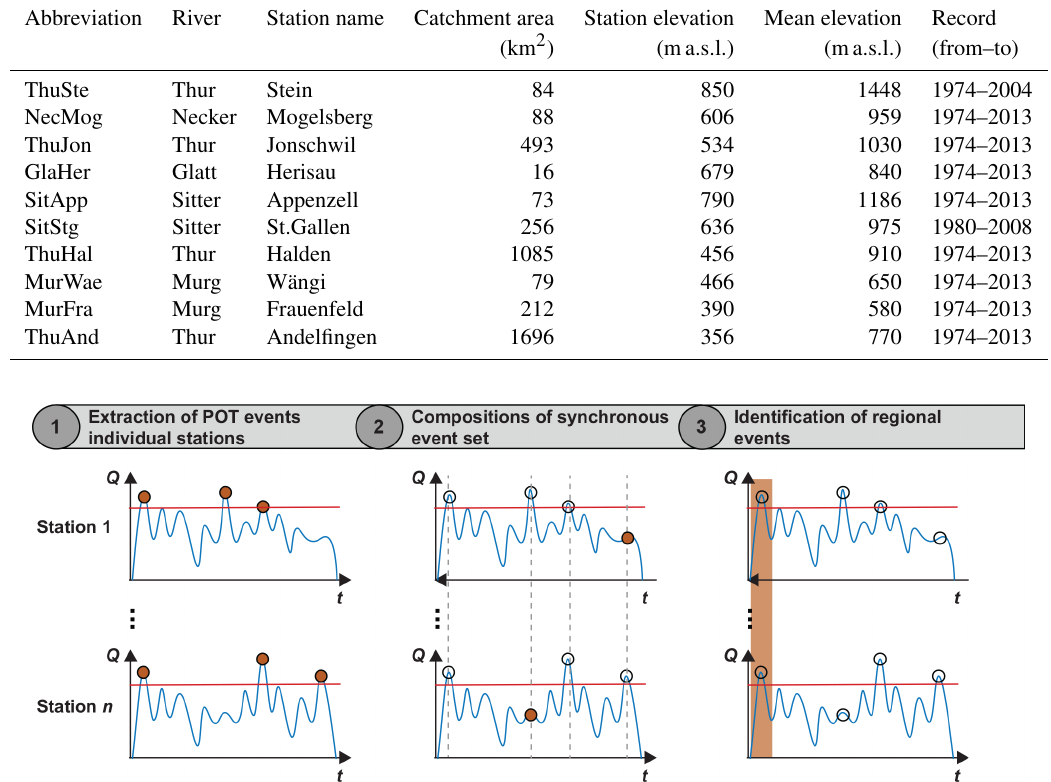
Figure 2. Illustration of the flood event identification procedure consisting of three main steps: (1) extraction of peak-over-threshold (POT) events at individual stations, (2) composition of a synchronous event set, and (3) identification of regional events within the synchronous event